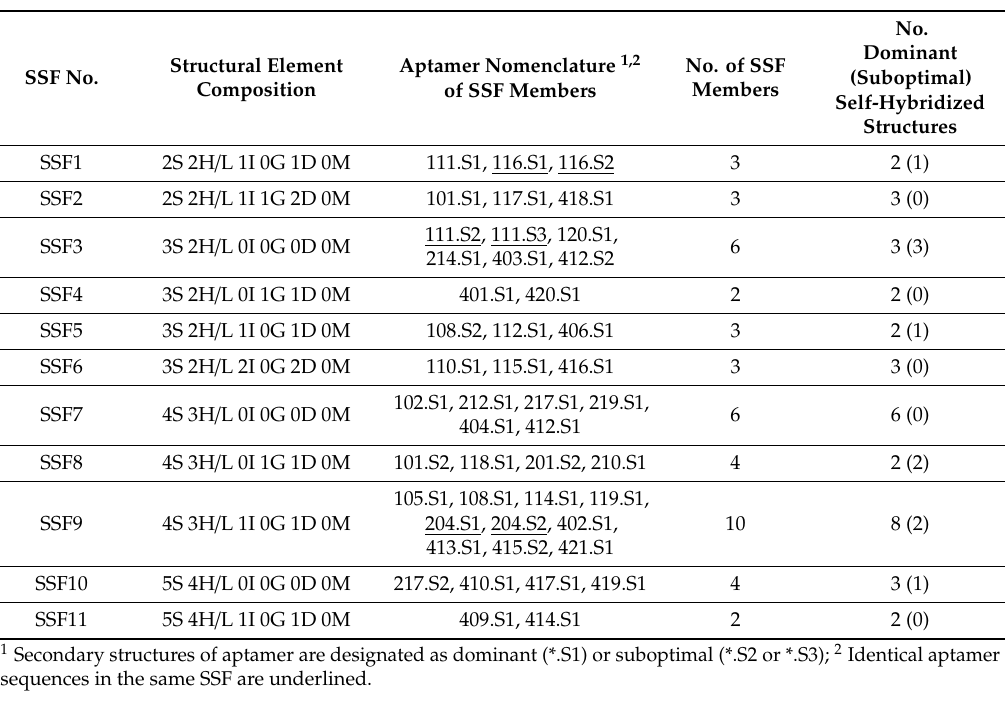
Table 1. List of secondary structure family (SSF) group number, structural element composition, aptamer nomenclatures, total number of members, and the numbers of dominant and suboptimal self ‐ hybridized structures for all 11 SSF assigned among all AuNR aptamers identified via CompELS.